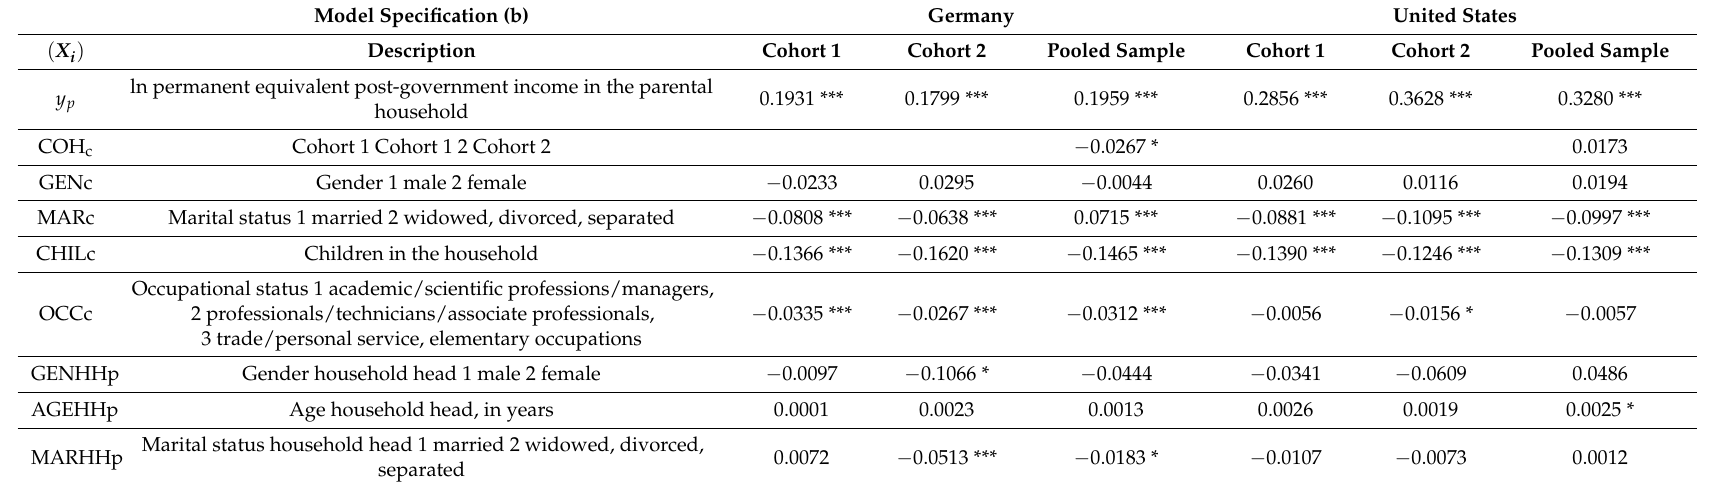
Table 5. Intergenerational income